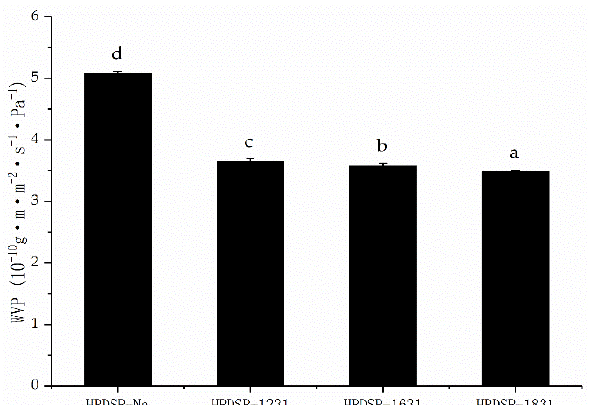
Figure 6. Water vapor permeability (WVP) of the HPDSP nanocomposite films. Results are quoted as means ± SD (standard deviation) of triplicate determinations. a–d: Different letters indicate significant differences among formulations ( p < 0.05).